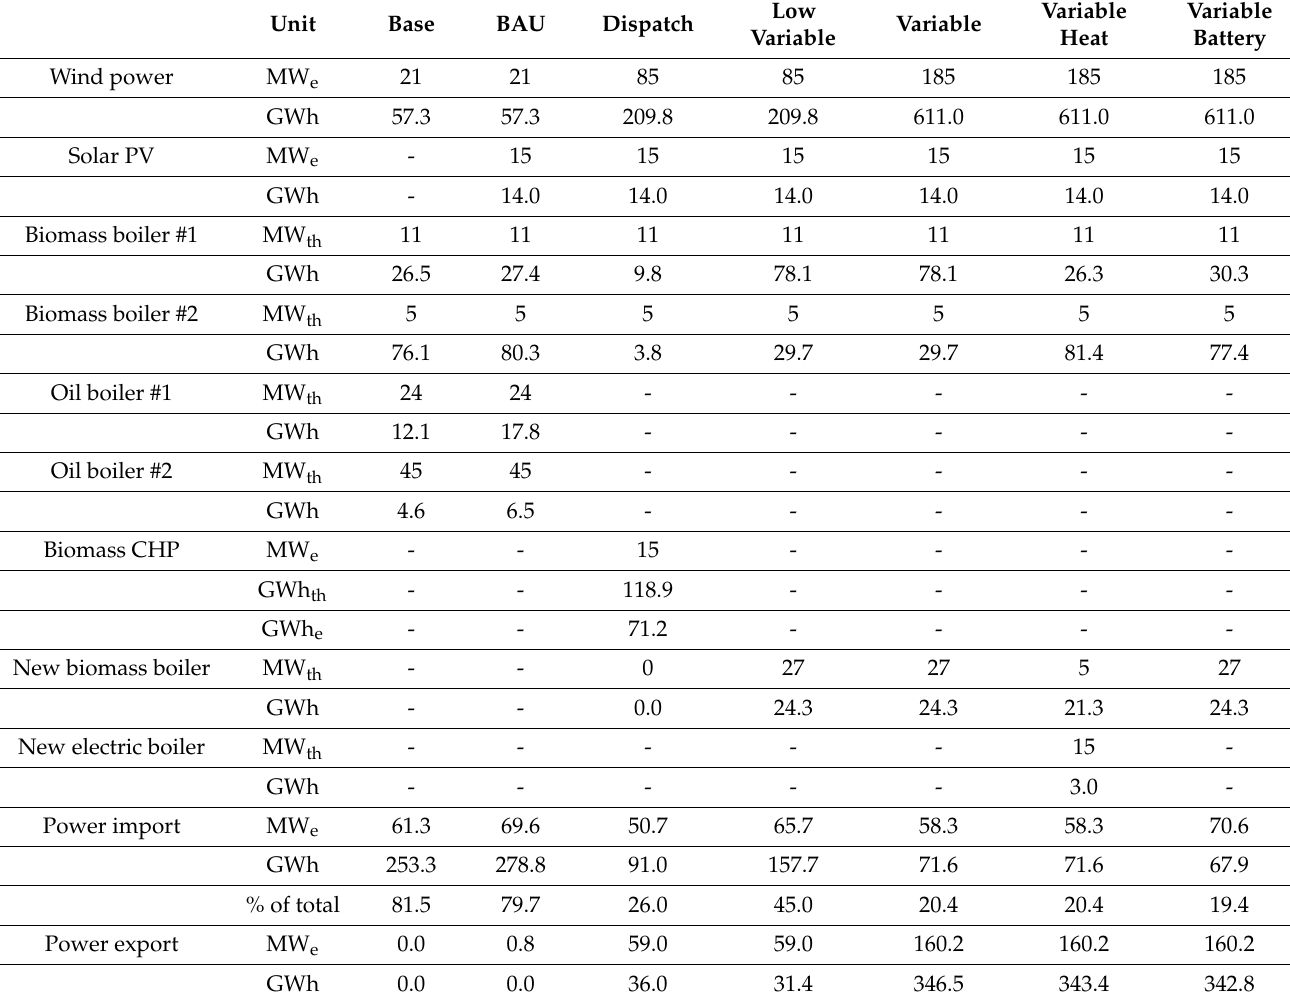
Table 2. Summary of the system operation in the simulated scenarios. For the units, the rated capacity and total annual production are shown. For power transmission, the maximum power, total annual transmission and percentage of total power consumption are